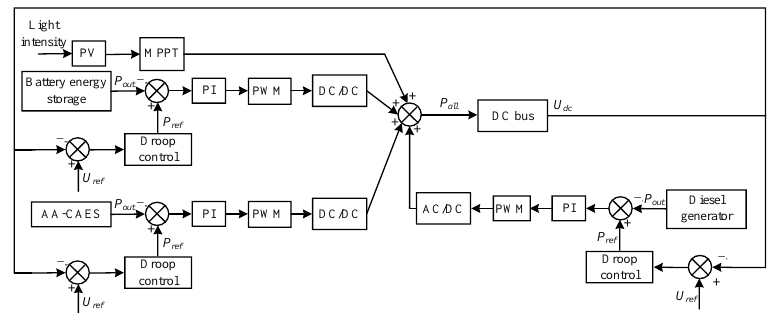
Figure 6. Control block diagram of DC microgrid system.